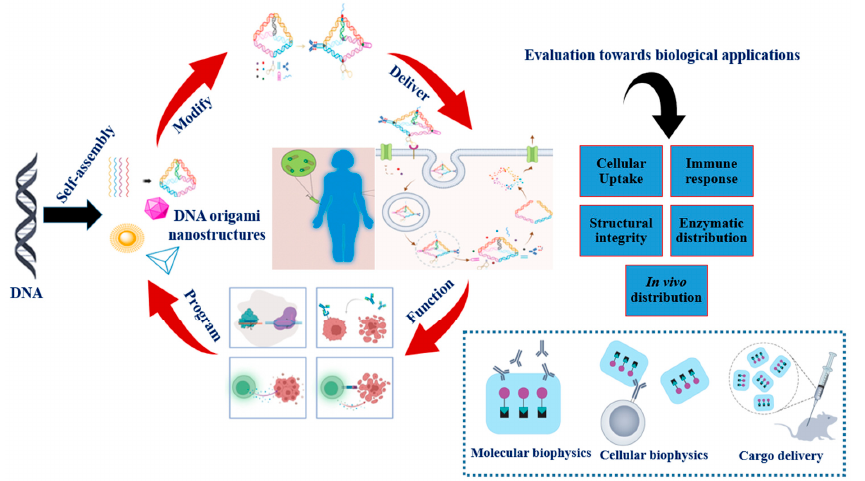
Figure 5. Current opportunities and challenges of DNA origami nanostructures for controlled therapeutic drug delivery.